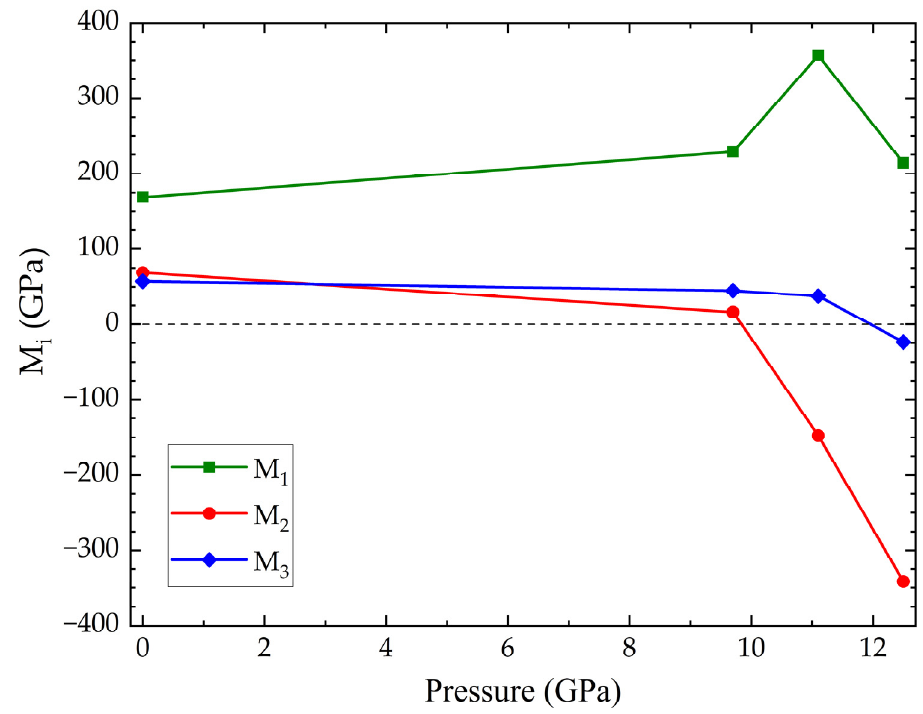
Figure 4. Generalized Born stability criteria (M i ) versus pressure for S-FeVO. In the figure M 2 and M 3 become negative at the conditions described in the text.